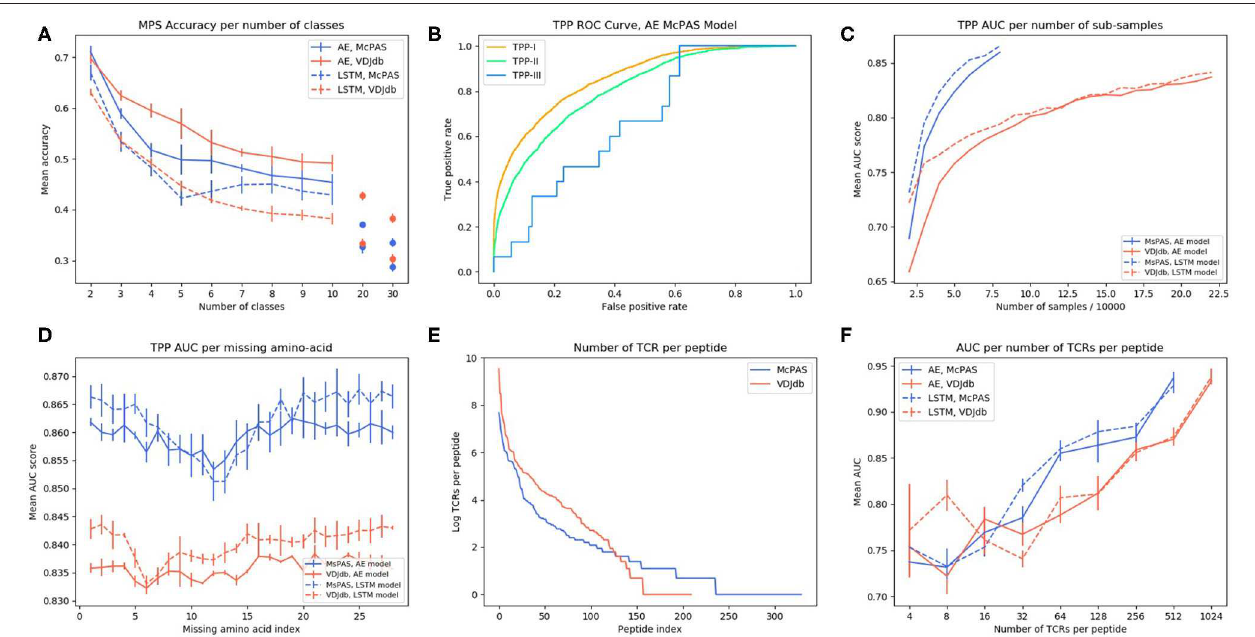
FIGURE 2 | (A) AE and LSTM models MPS accuracy per number of peptide classes in McPAS-TCR (23) and VDJdb (27) datasets. (B) ROC curve of TPP-I, II, and III AE model performance on McPAS dataset. (C) AUC for TPP-I as a function of the sub-sample size. (D) AUC of TPP-I per missing amino-acids index. (E) Number of